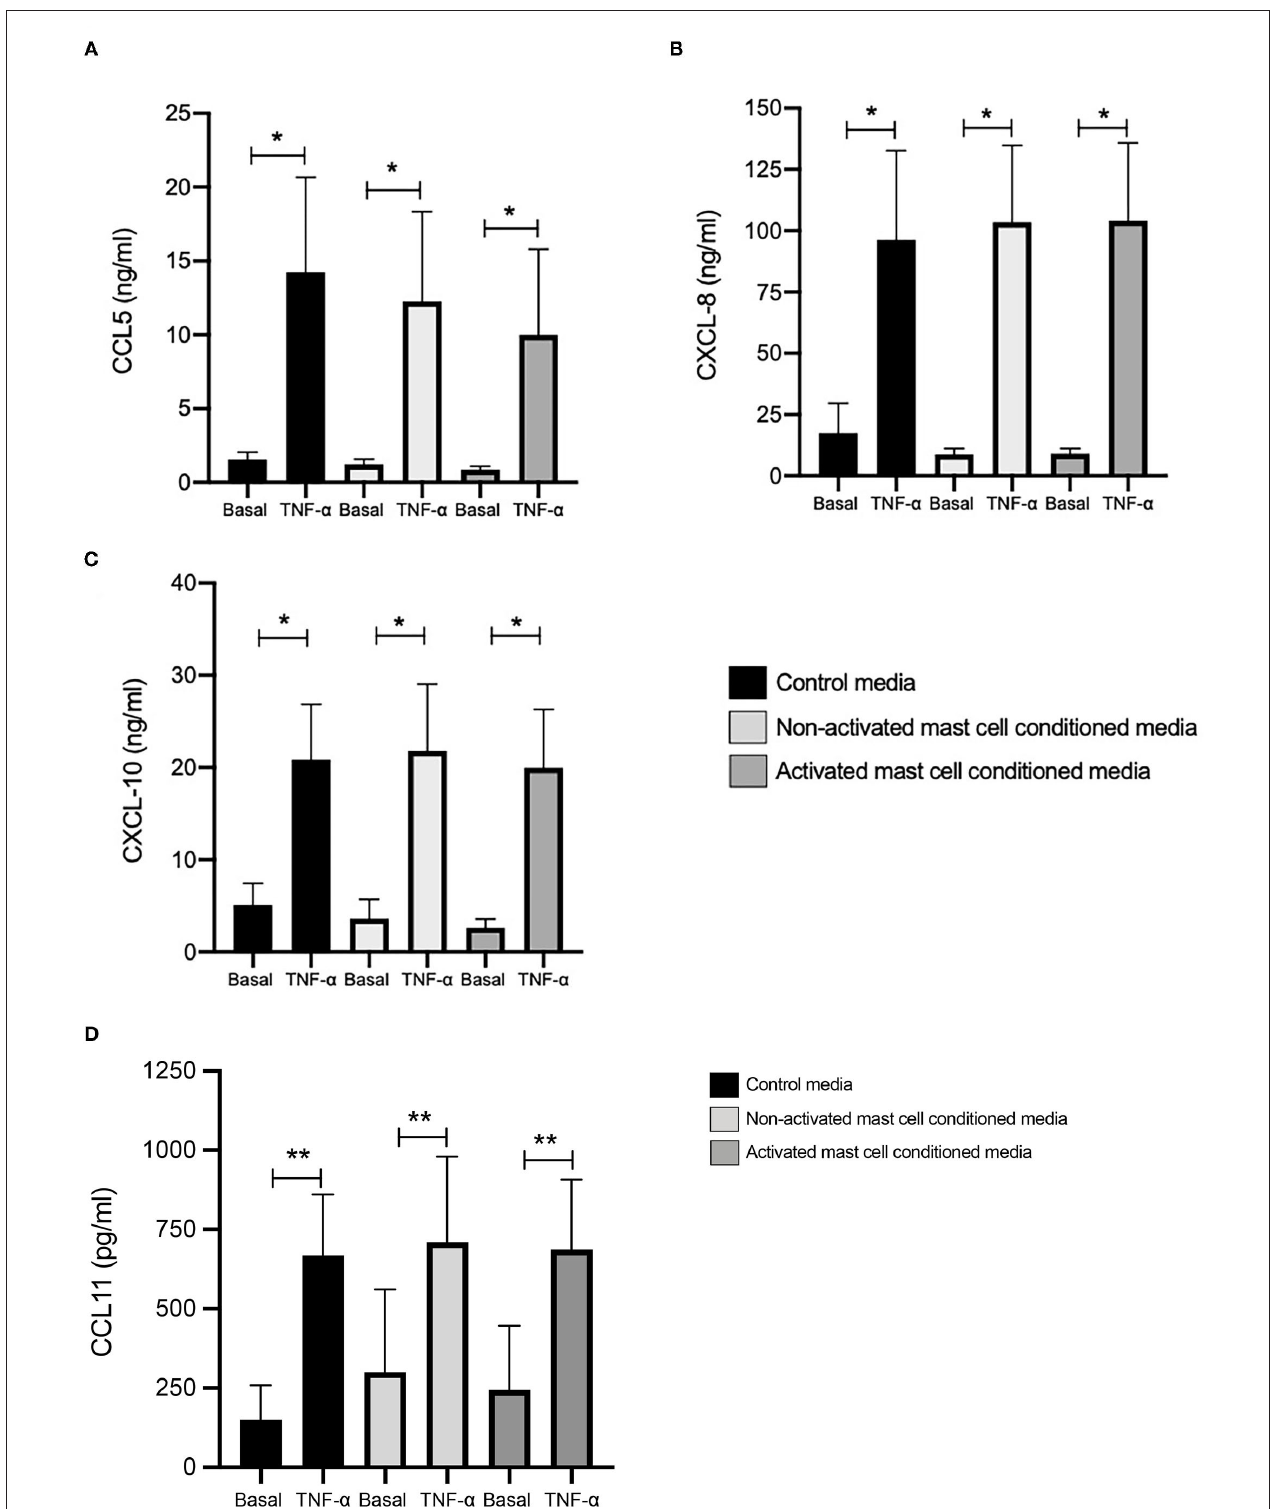
FIGURE 1 | TNF α -induced chemokine production in ASM cells treated with control and 24-h mast cell conditioned media. Healthy ASM cells were pre-treated with control MC media, 24-h non-activated and activated mast cell conditioned media for 24h. ASM cells were then washed and stimulated with TNF- α (10ng/ml). The chemokine levels of CCL5 (A) , CXCL8 (B) , and CXCL10 (C) were assessed by ELISA. Data were presented as ng/ml of protein as Means ± SEM of n = 6 different cell lines. Comparisons between conditions were made using paired t -test (* p < 0.05).